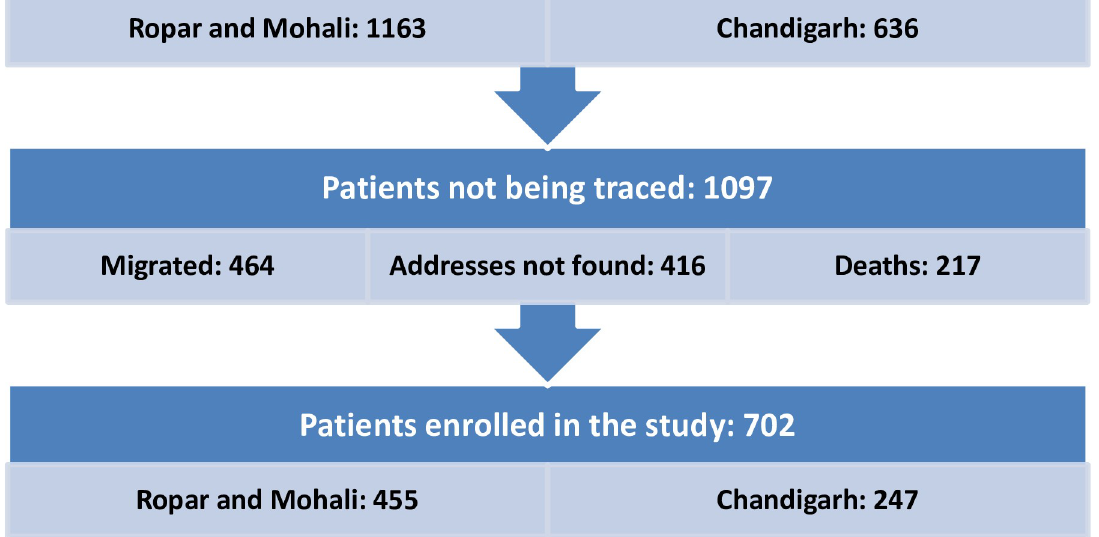
Fig 1. Flowchart showing process of sample